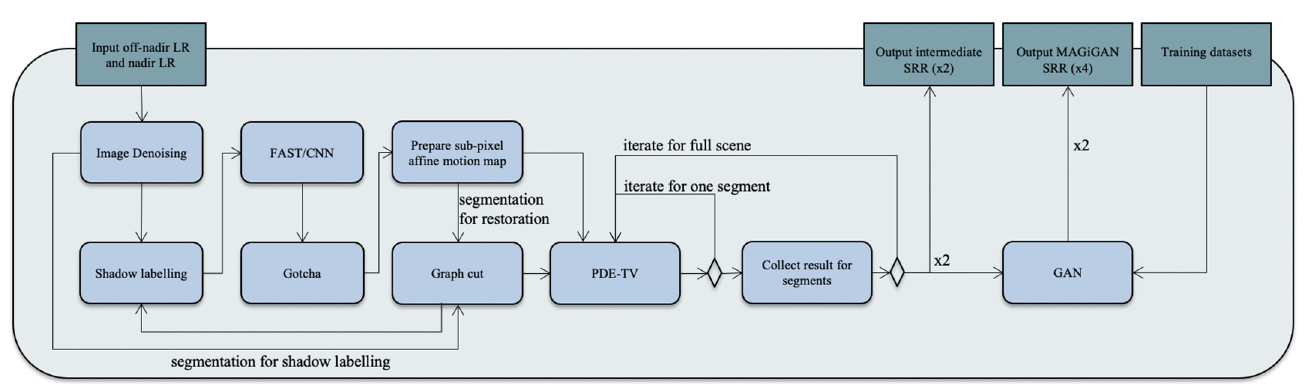
Figure 2. Simplified flow diagram of the MAGiGAN SRR system described in [1]. N.B.: darker coloured boxes represent the inputs and outputs.